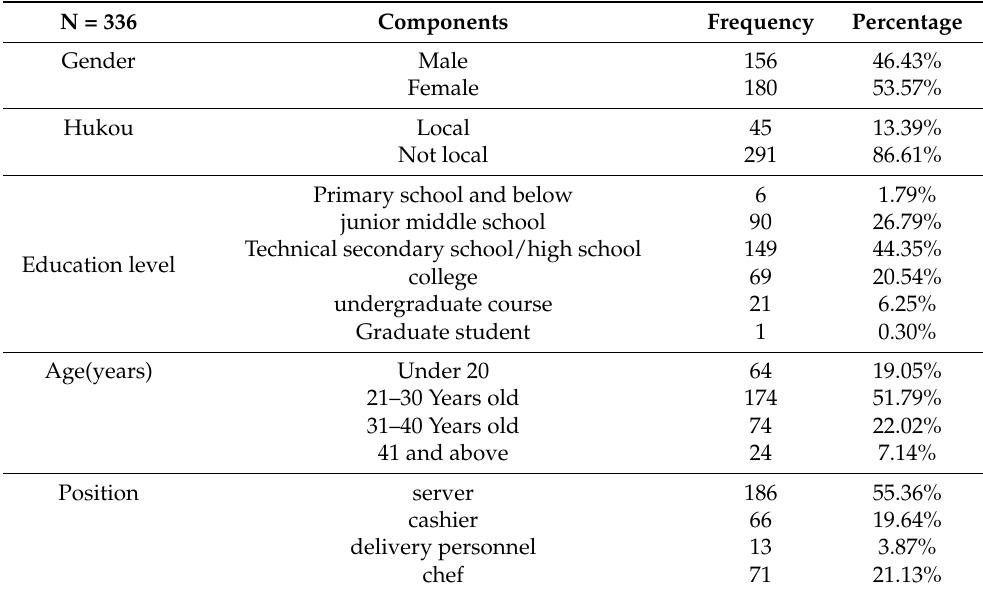
Table 1. Sociodemographic Characteristics of